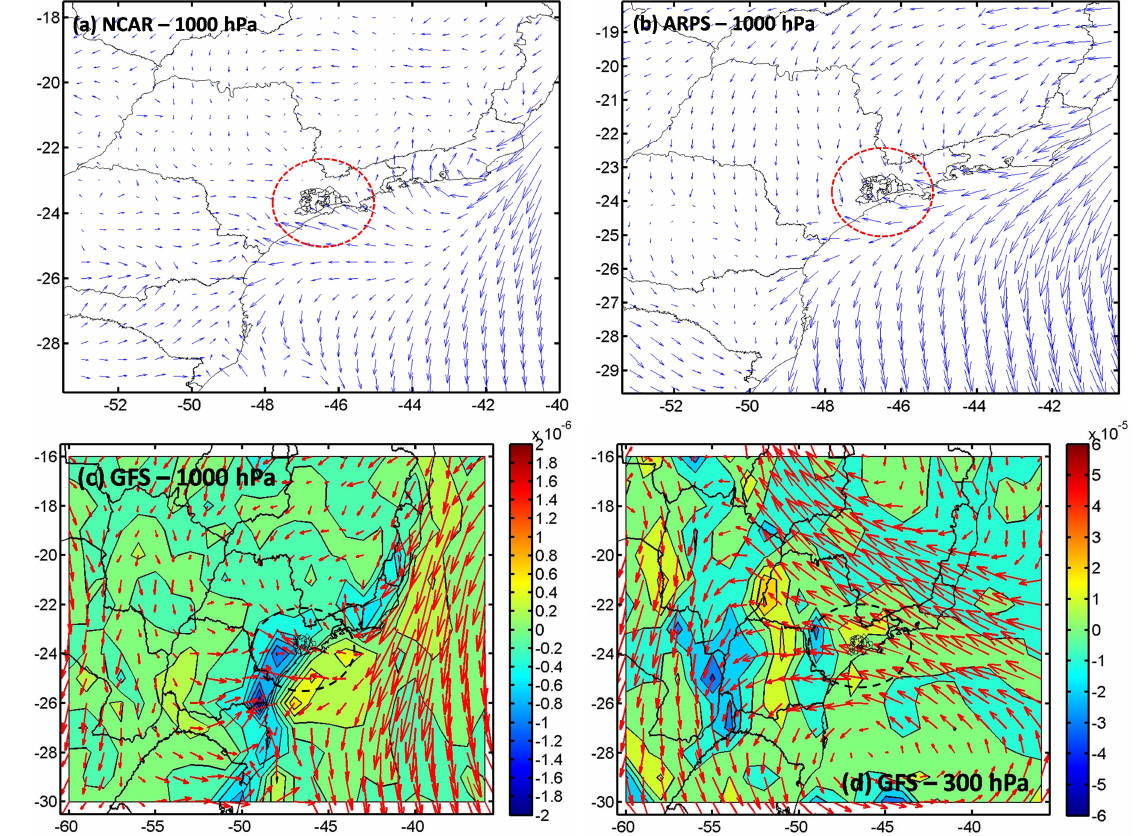
Figure 5. Comparison of ( a ) NCEP-NCAR reanalysis data (resolution 0.5 ◦ ) and ( b ) ARPS model simulated flow circulation (m s − 1 ) for the grid of 9 km and 1000 hPa. Moisture and mass divergence fluxes (g kg − 1 s − 1 ) from the GFS model for ( c ) 1000 hPa and ( d ) 300 hPa at 18 UTC (15 LT) of 12 January 2015. Latitudes, longitudes and geopolitical contours are indicated. The circles indicate the area around the